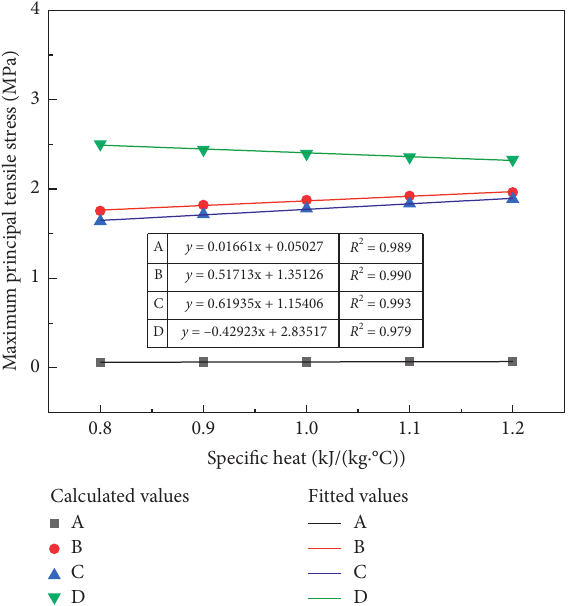
Figure 7: The calculated and fitted maximum principal tensile stress at each point with a different specific